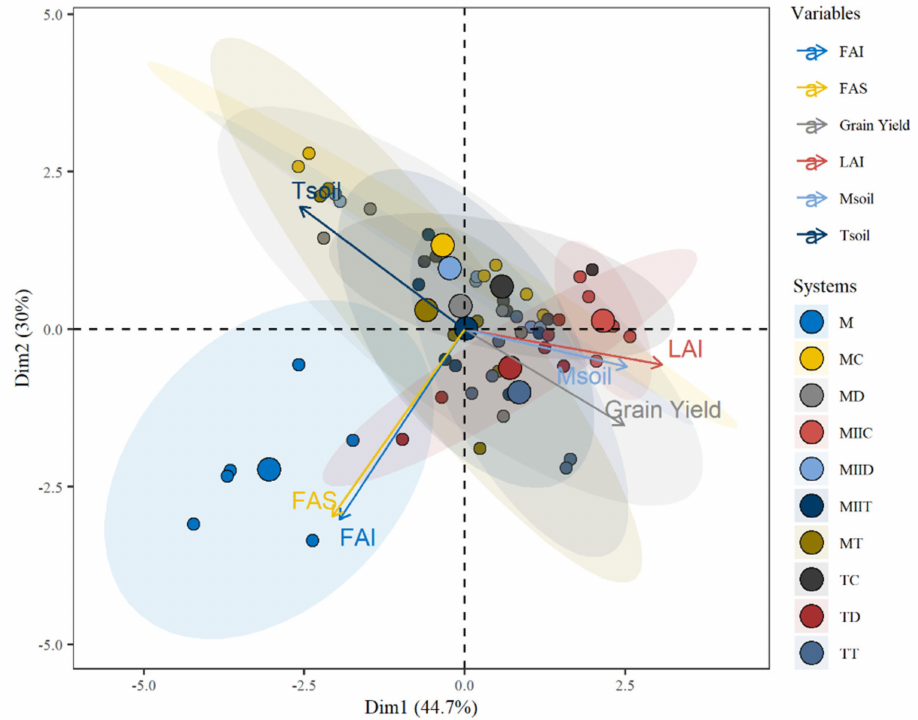
Figure 9. Biplot of principal component analysis based on variables studied in maize Push–Pull systems established in Yautepec, Morelos, Mexico. FAI = Fall Armyworm Incidence; FAS = Fall Armyworm Severity; LAI = Leaf Area Index; Msoil = Soil moisture; Tsoil = Soil temperature. For abbreviations, see Table